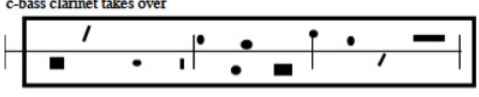
Figure 17. Contrabass clarinet solo in bar